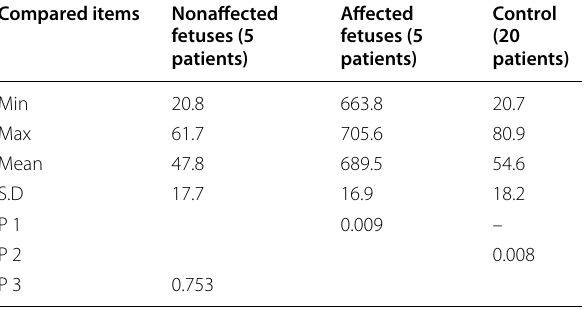
P1: comparison between nonaffected and affected